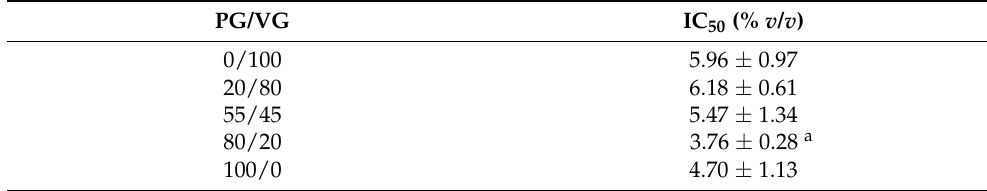
Table 1. IC 50 values of cytotoxicity induced by different PG/VG ratios in